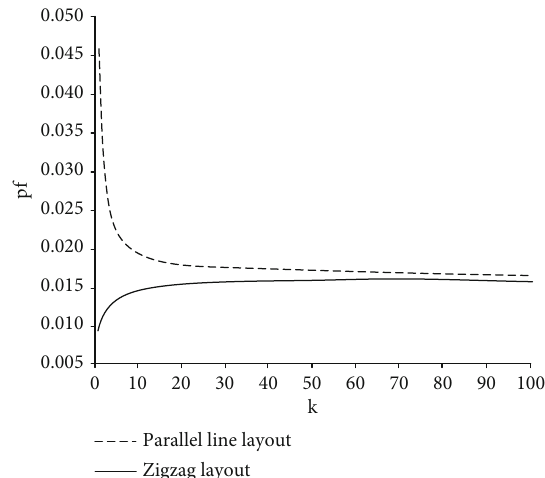
Figure 3: The pf curve of two layout modes under di ff erent k values.